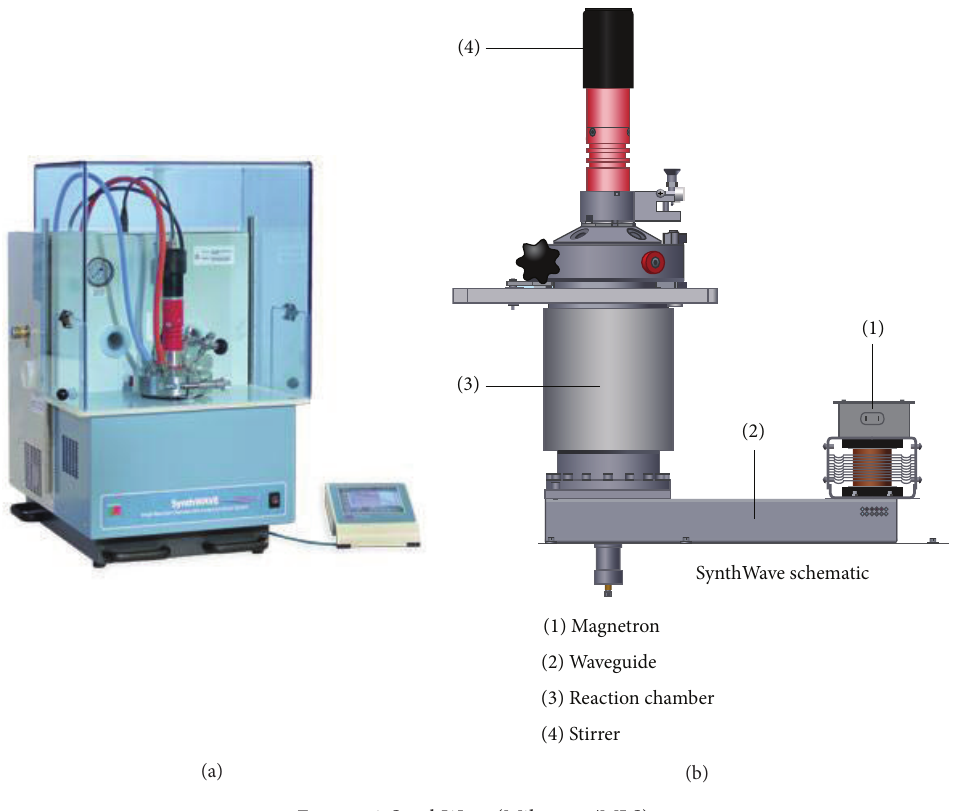
Figure 6: SynthWave